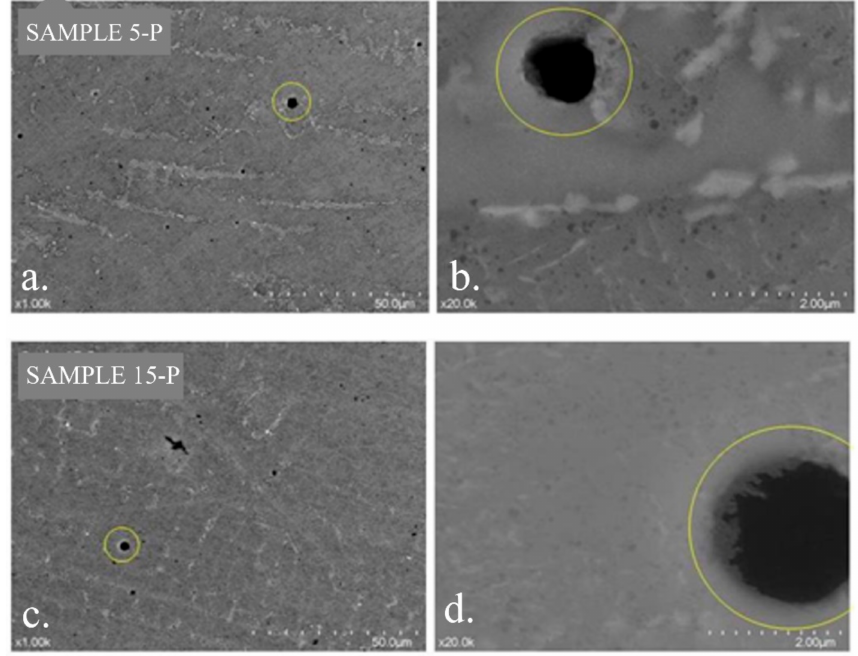
Figure 9. Surface SEM analysis of the samples, demonstrating the presence of pores (marked with a yellow circle): ( a , b ) sample 5-P; ( c , d ) sample 15-P. Surface SEM images obtained under higher magnification show, for sample 5-O3, an inhomogeneous polycrystalline structure and the presence of differently shaped and sized crystals, suggesting an uneven contribution of the two types of oxides. However, similar SEM images of sample 15-O3 show a more homogeneous crystalline structure regarding the crystal size (Figure 10).